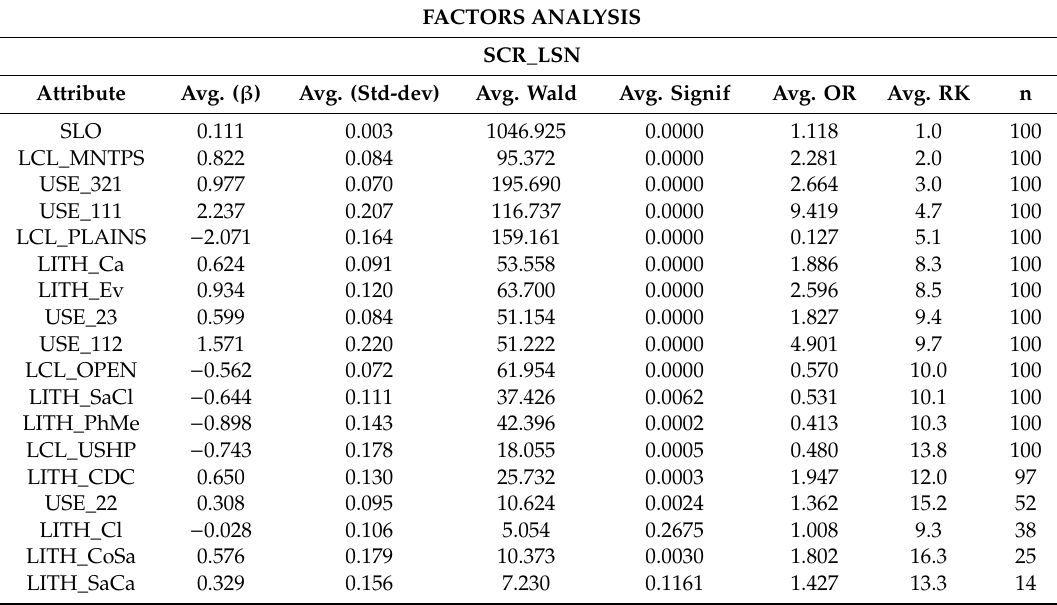
Table 5. Factors analysis for SCR_LSN.